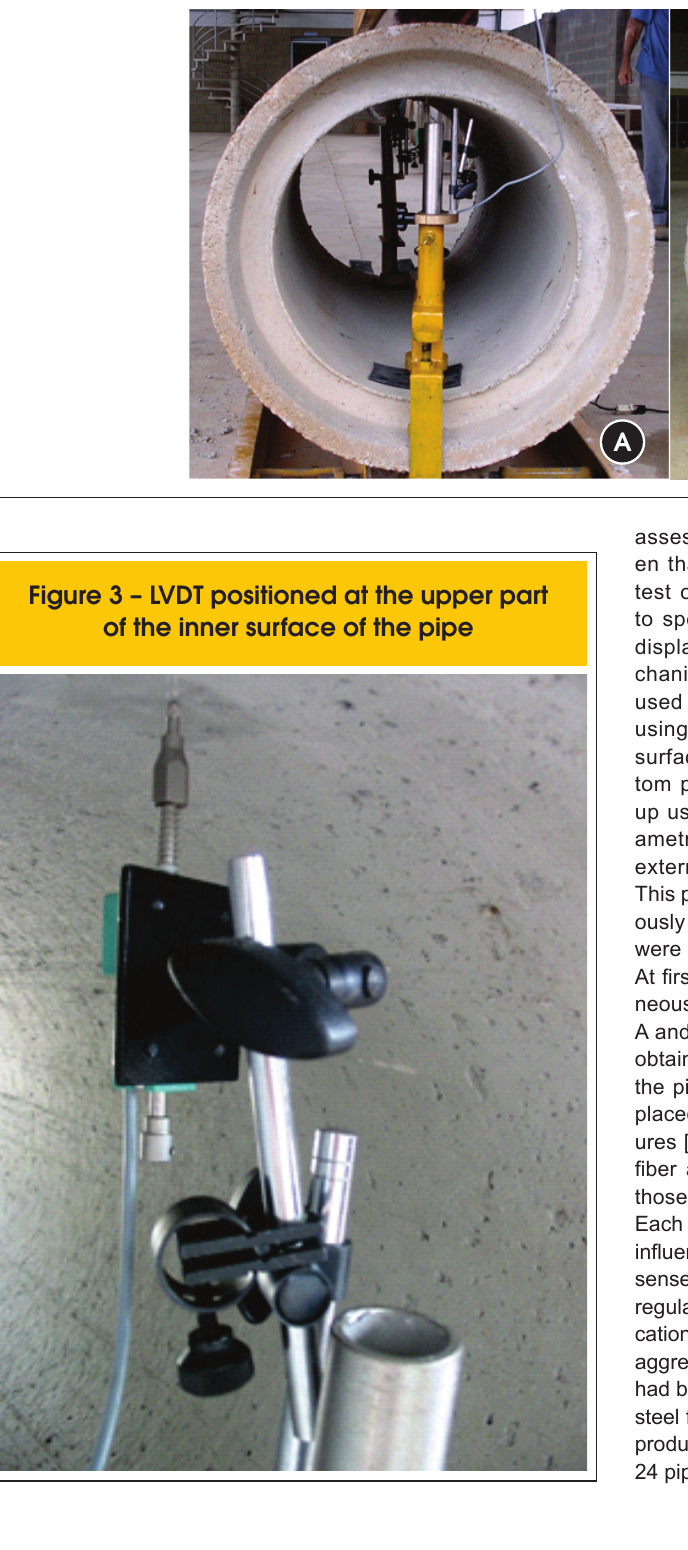
Figure 2 – Configurations adopted for the measurement of displacements st